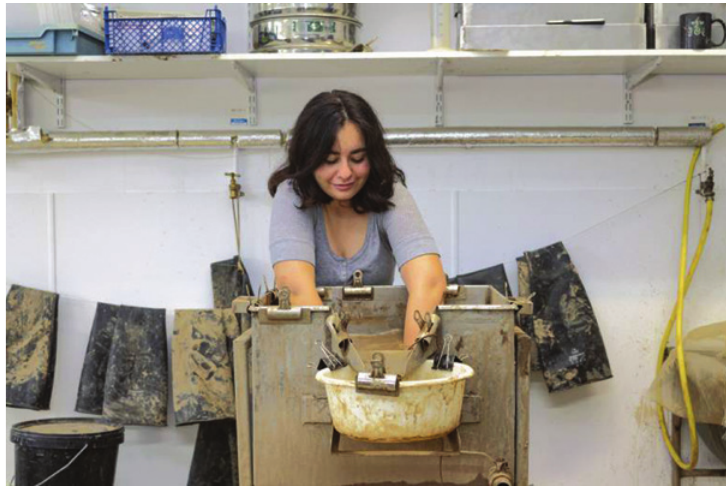
Figure 4 IoA student Iva Popova on placement with Archaeology South-East. (Image credit: Archaeology